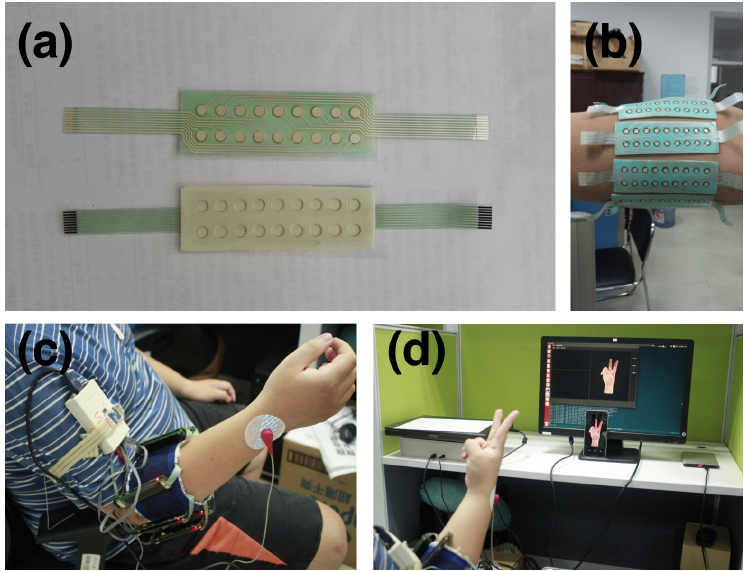
Figure 1. The acquisition setting-up: ( a ) The HD-sEMG electrode array; ( b ) 8 HD-sEMG electrode arrays on the right forearm; ( c ) The HD-sEMG acquisition device ready for capture; ( d ) The software subsystem to present the guided hand gesture and record HD-sEMG data